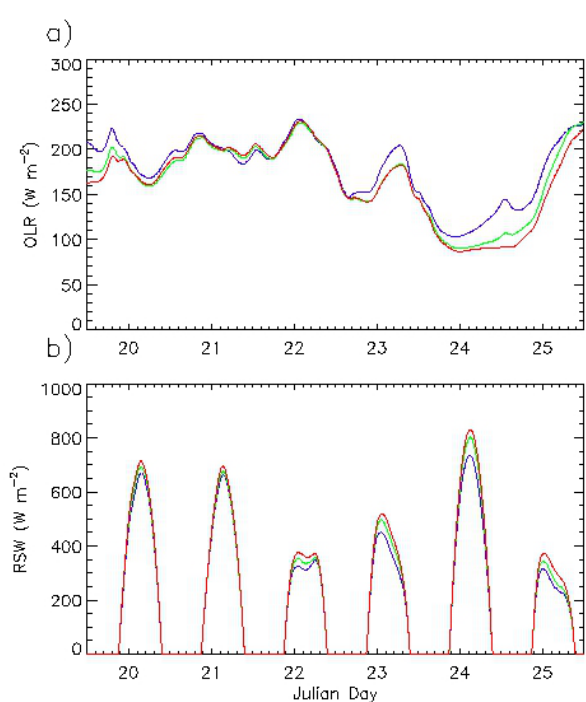
Fig. 12. Timeseries of ensemble- and horizontally-averaged TOA (a) outgoing longwave radiation (OLR) and (b) reflected shortwave radiation (RSW), for PRIS (blue), POLL (green), and SPOLL